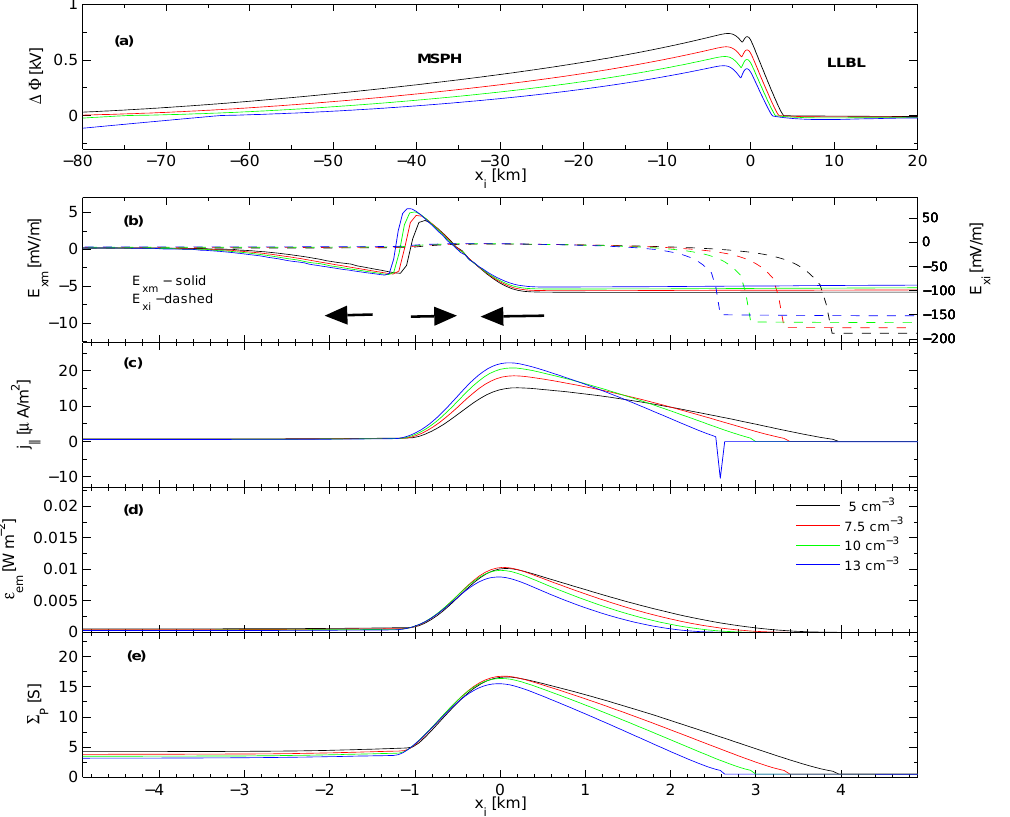
Fig. 7. Solutions of Eq. (4) and derived quantities obtained for a non-uniform height-integrated Pedersen with background conductivity 6 P 0 = 0 . 5 (see Eq. 2). Different colors illustrate solutions obtained for various profiles of 8 m obtained for four different LLBL plasma densities. The values of n − corresponding to each color are given in the legend of panel (d) . See caption of Fig. 5 for an explanation of LLBL data from all